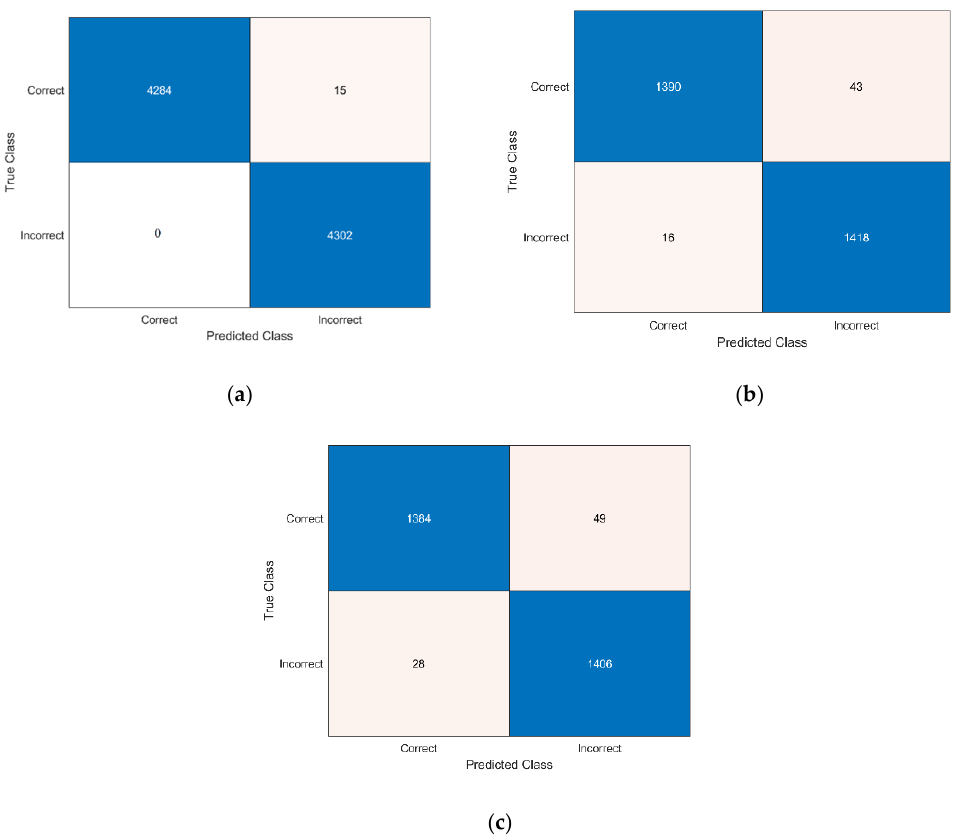
Figure 7. Accuracy and loss results for WMNet training. ( a ) Accuracy and ( b ) loss.